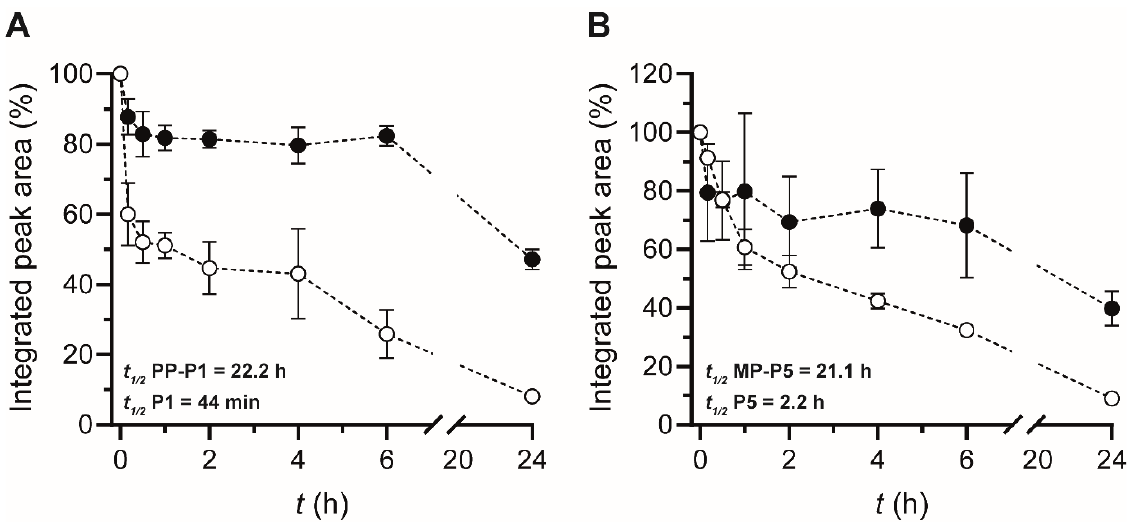
Figure 2. PPCs and peptides serum stability over 24 h. ( A ) PP-P1 (black) and P1 (white). ( B ) MP-P5 (black) and P5 (white).